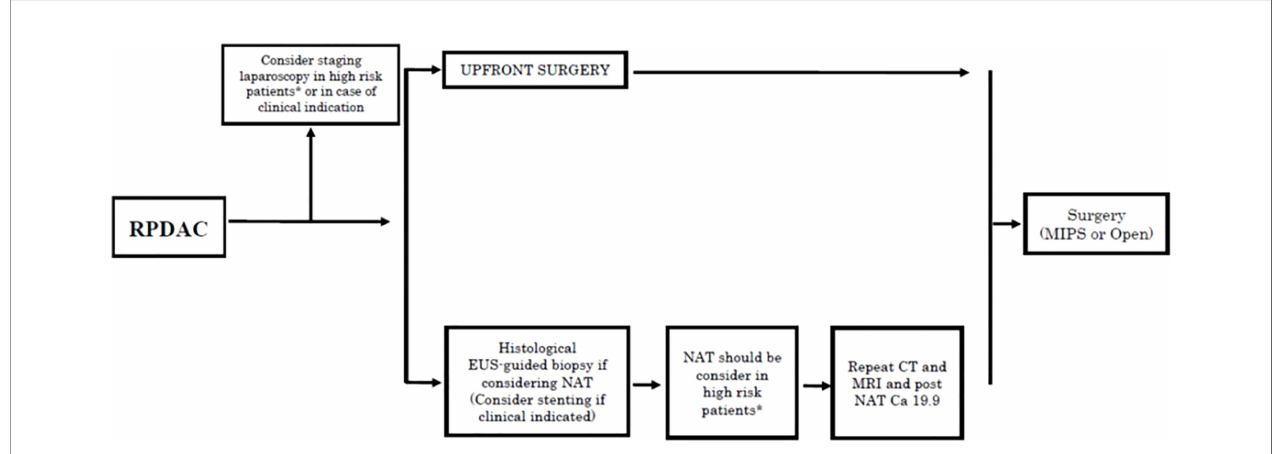
FIGURE 1 | Treatment algorithms for resectable pancreatic cancer reported in the NCCN Guidelines Version 1.2021. (6). RPDC, Resectable pancreatic ductal adenocarcinoma; NAT, neoadjuvant treatments; EUS, endoscopic ultrasound; CT, computed tomography; MRI, Magnetic resonance; MIPS, minimally invasive pancreatic surgery. *High risk patients: Patiens with high risk features in terms of radiological (large primary tumor, large lymphonodes suspected for metastatic) and/ or biological fi ndings (Ca 19.9 > 500 U/ml in case of absence of biliary obstruction and/or cholangitis, extreme irradiated pain, excessive weight